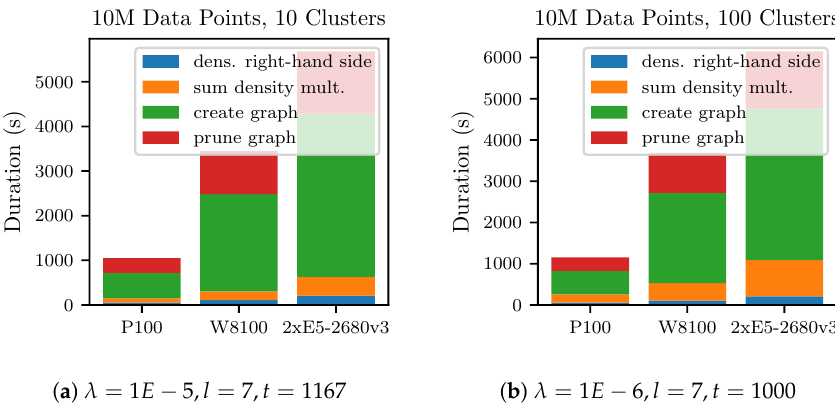
Figure 7. The duration of the node-level experiments with 10 million data points.